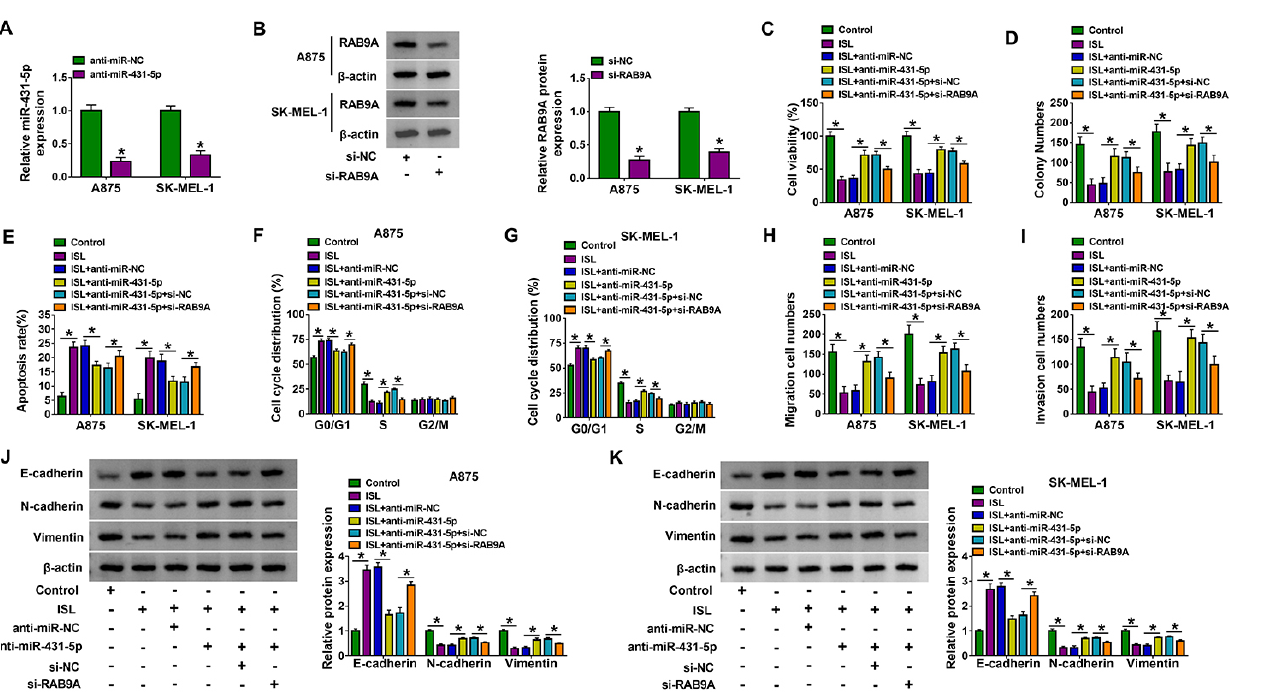
Figure 6. The miR-431-5p inhibition counterbalanced the ISL-induced antitumor function by upregulating RAB9A in melanoma cells. The inhibitory efficacies of (A) anti-miR-431-5p and (B) si-RAB9A were analyzed through RT-qPCR and western blot, respectively. The control, ISL (60 µg/mL), ISL+anti-miR-NC, ISL+anti- miR-431-5p, ISL+anti-miR-431-5p+si-NC and ISL+anti-miR-431-5p+si-RAB9A groups were designed in A875 and SK-MEL-1 cells. CCK-8 assay and colony formation assay were conducted to determine (C) cell viability and (D) proliferation. Flow cytometry was conducted to examine (E) cell apoptosis and (F, G) cell cycle progression. Transwell assay was implemented to assess (H) cell migration and (I) invasion. (J-K) Western blot was performed to analyze the protein levels of EMT-associated markers. * p < 0.05.